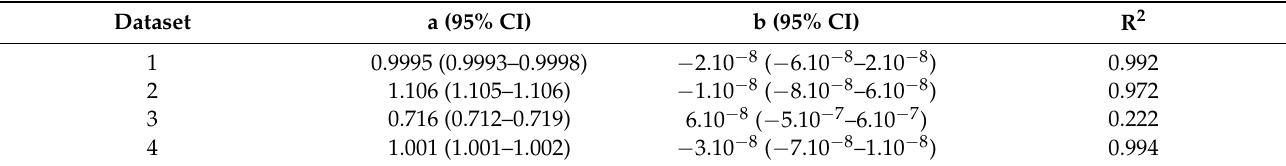
Figure 15. Correlation between signal amplitudes measured by channel 2 as a function of channel 1 ( n = 48,000 samples). Channel identification as per Figure 4a. Four different panels are shown, illustrating the cross correlation for four different datasets. Table 3. Linear fit for the samples acquired by channel 1 in function of samples acquired by channel 2 in the form of y = ax + b. The coefficient of determination R 2 is provided as a measure for the quality of the fit together with the 95% confidence intervals of the fitted coefficients.